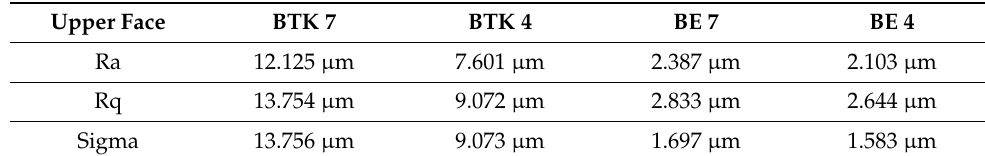
Table 2. Roughness parameters on upper faces of both samples.